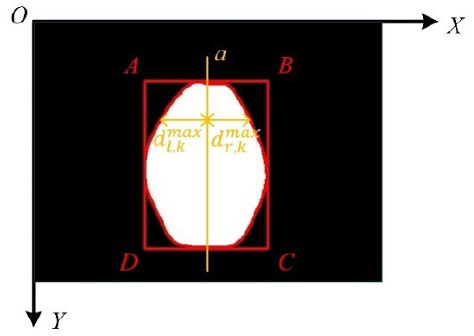
Figure 2. Schematic diagram of symmetry feature calculation.